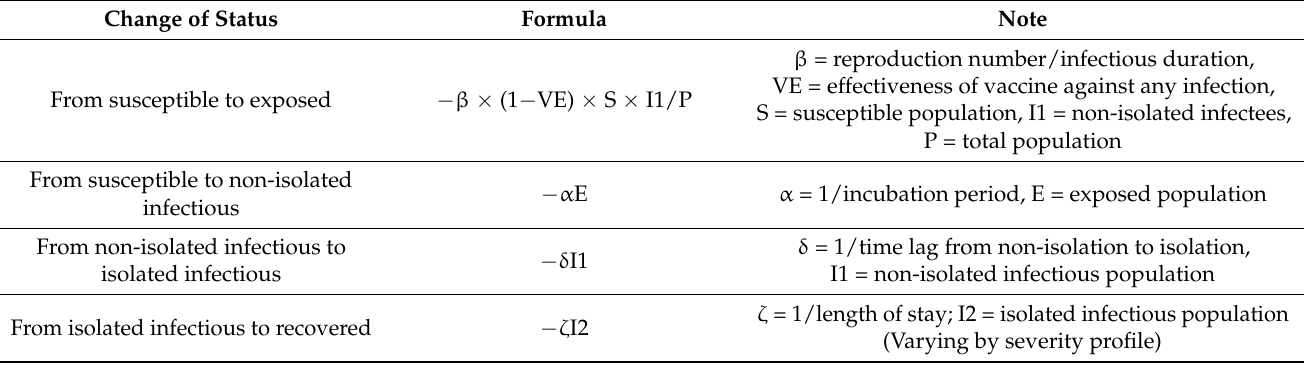
Table 3. The essential formulas of the model.